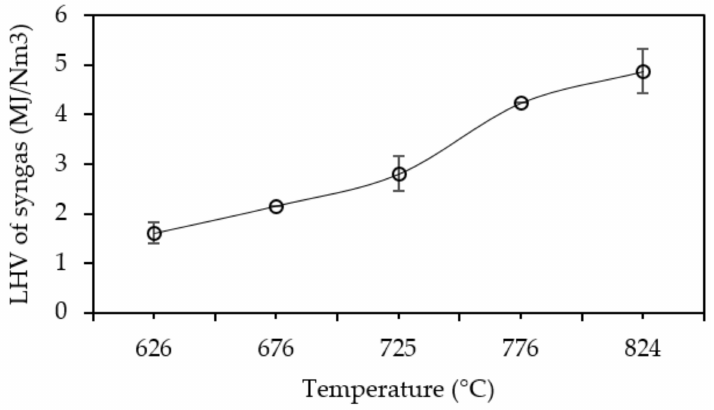
Figure 5. The e ff ect of temperature on syngas lower heating value